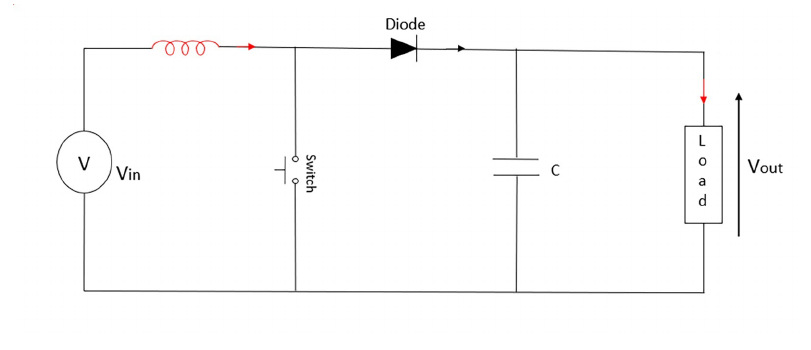
Figure 2. DC-DC boost